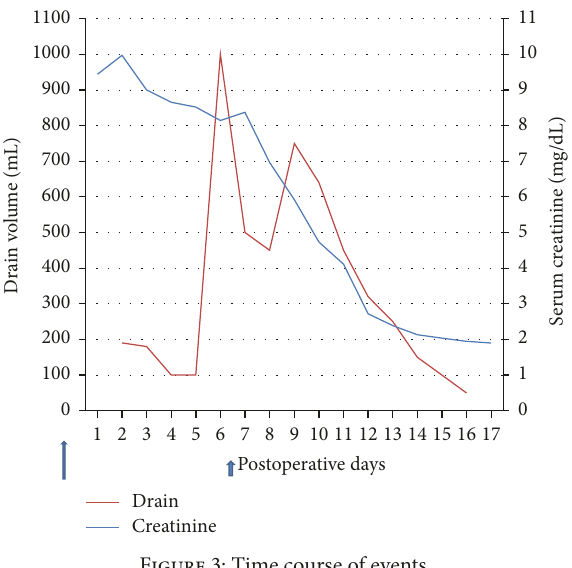
Figure 3: Time course of